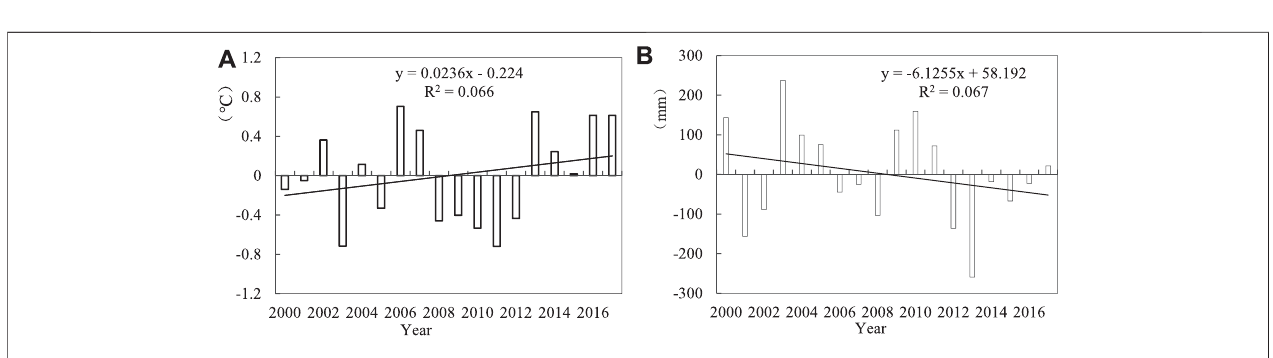
FIGURE 8 | Temperature (A) and precipitation (B) anomalies with trends over